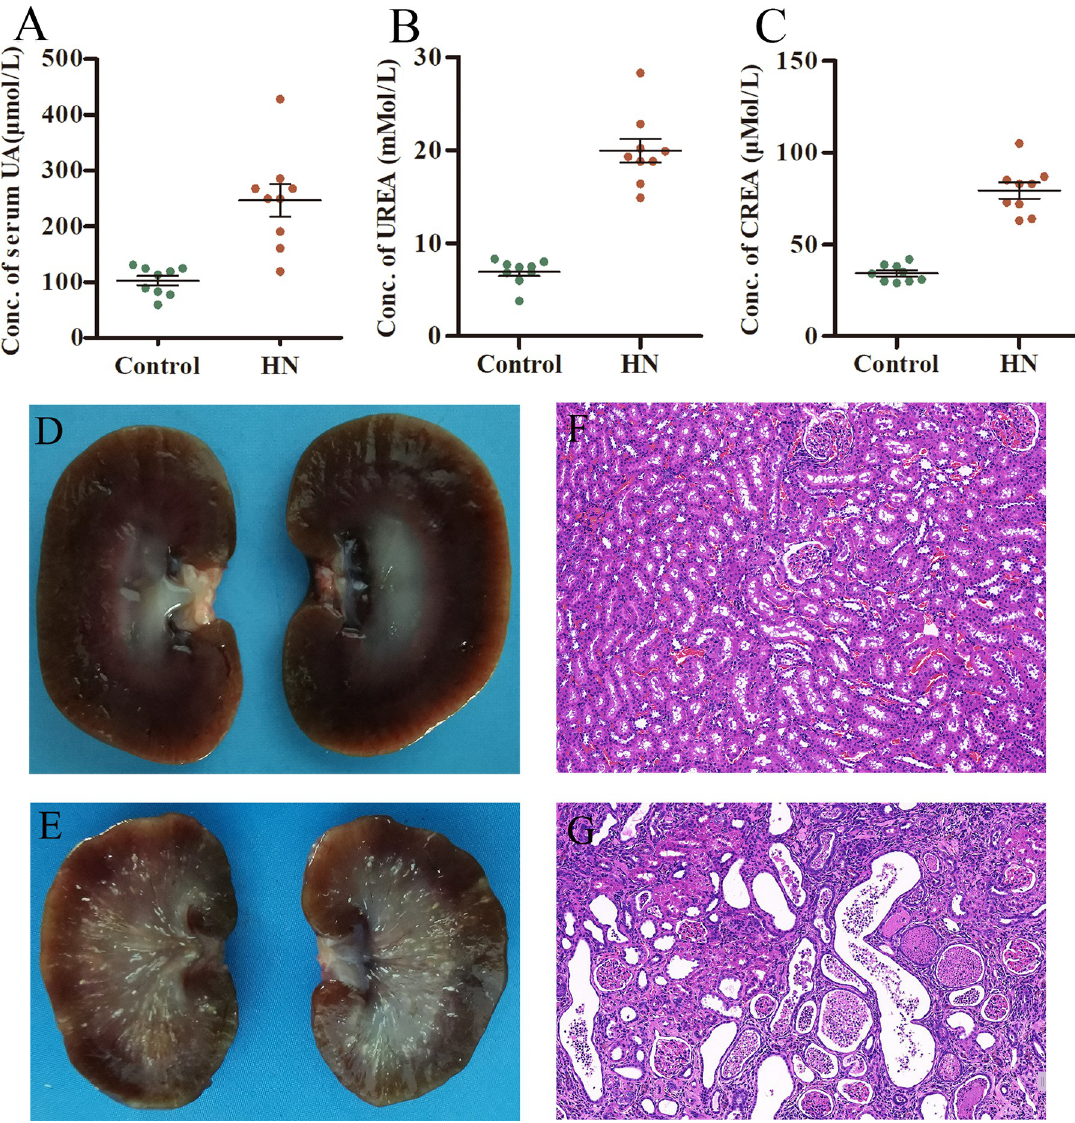
Fig 1. Characteristics of rats fed a normal or HUAD. (A) There were differences in the serum UA concentration, (B) serum UREA concentration and (C) serum UREA between HN rats (n = 9) and normal control rats (n = 9). For the comparison of quantitative data between groups, Student’s t-test was used. Differences in means were considered statistically significant at � P < 0.05. (D) Kidney longitudinal section photo of control rats. (E) Kidney longitudinal section photo of HN rats. (F) Kidney microscopic image of control rats. (G) Kidney microscopic image of HN rats. HN, hyperuricaemic nephropathy.